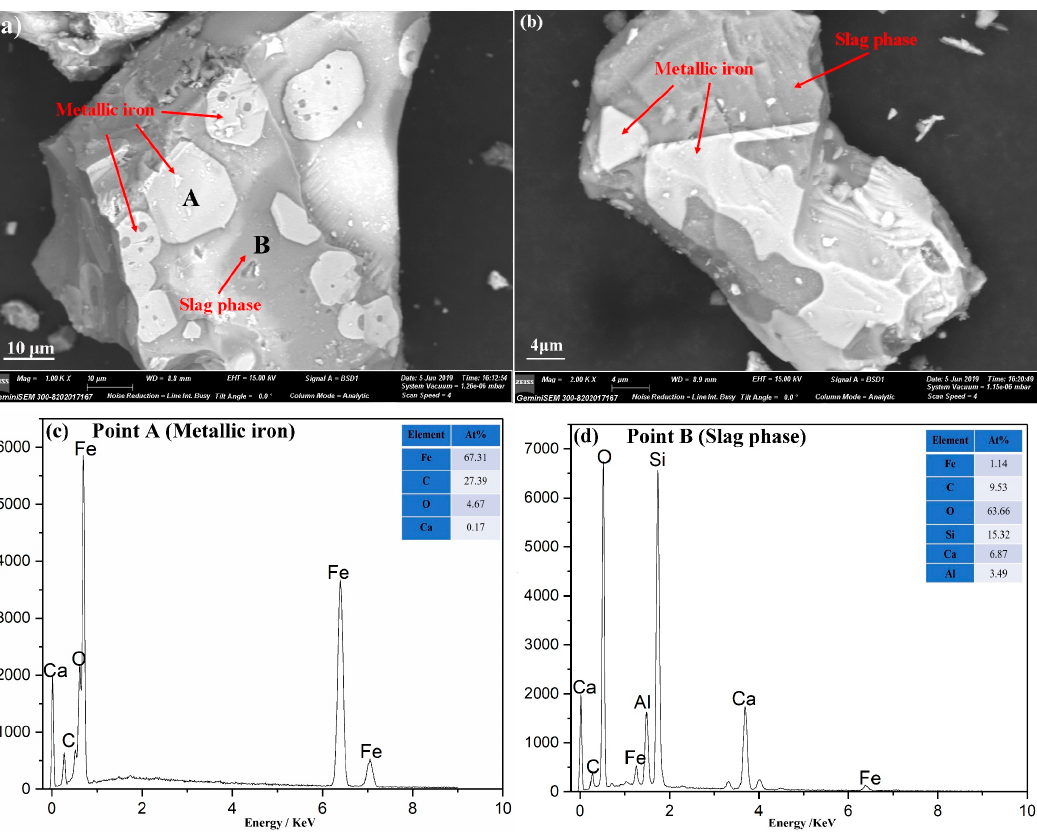
Figure 10. The micrography of the direct reduction of iron (DRI) product ( a , b ); the EDS result of point A ( c ); the EDS result of point B ( d ). Table 4. Chemical component of DRI product (wt.%).